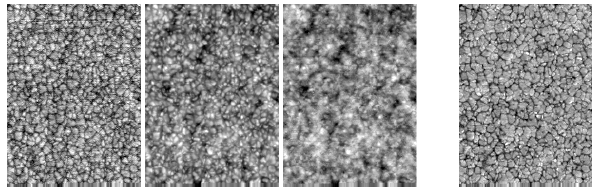
Figure 2. Three left frames – LOS velocity maps for the layers b 1 , b 7 , c 4 (line wing, above half maximum position and line core respec- tively). Dark areas correspond to downflow. Right frame – the LOS velocity difference between b 7 and b 3 , layers that is proportional to LOS velocity gradient ∆v LOS / ∆h . Hinode observation session 20191109_1334, cos( θ ) = 0.985. Fe I λ 6301 Å